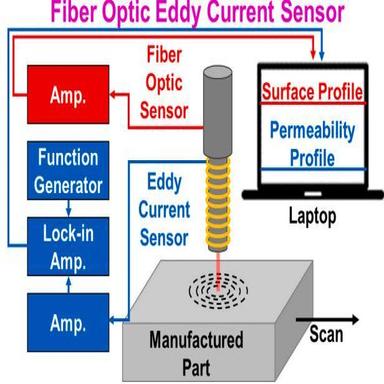
Schematic diagram of the fiber optic eddy current sensor.